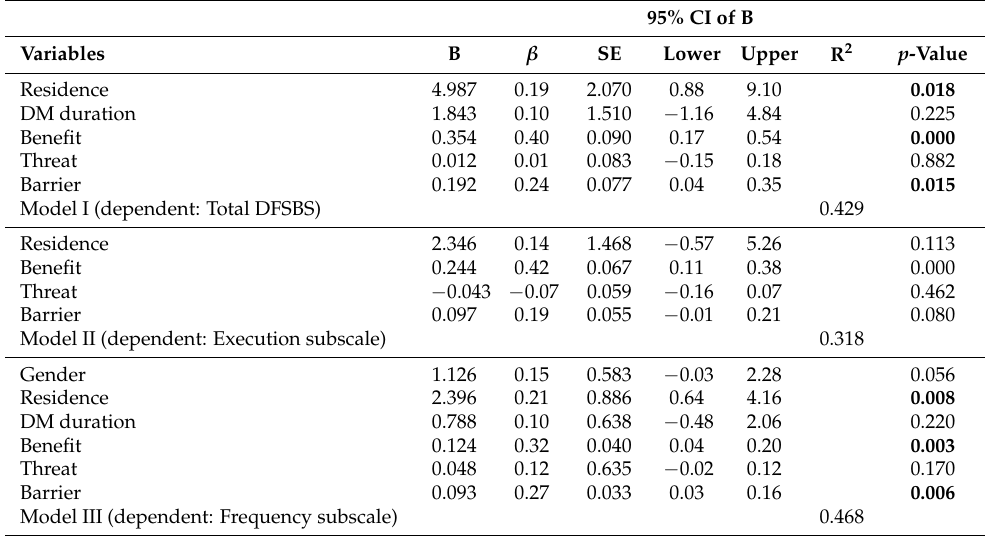
Table 4. Multivariable linear regression models predicting diabetic foot self-care behavior.